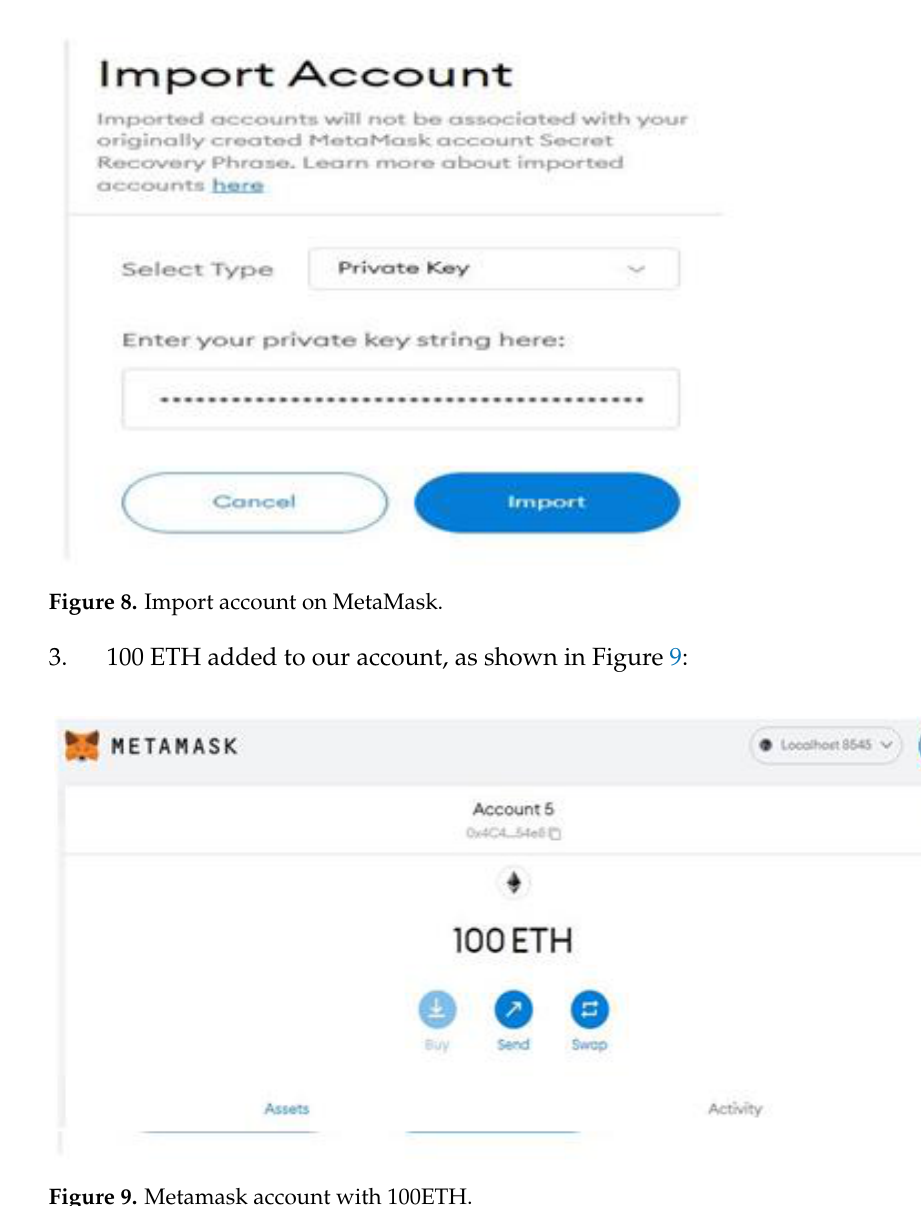
Figure 7. Available accounts to Ganache.